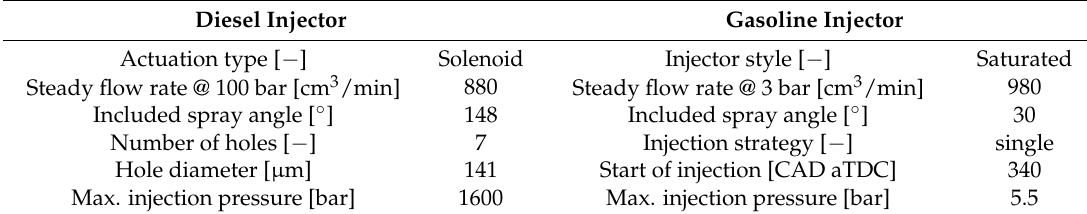
Table 3. Physical and chemical properties of the fuels.